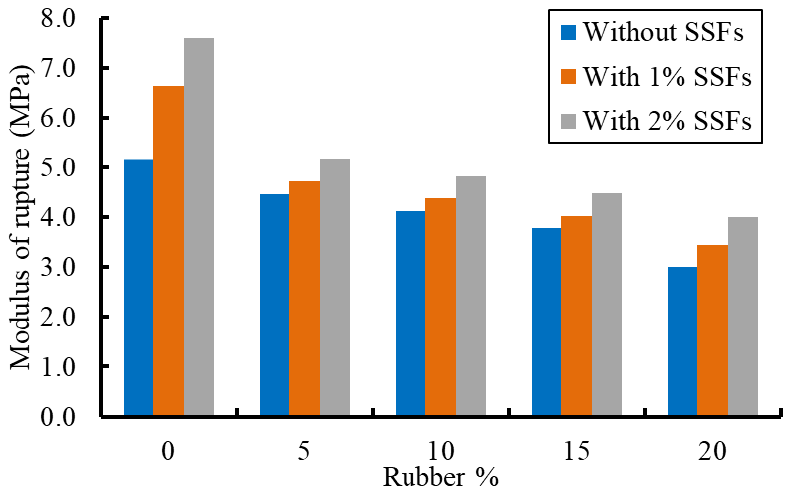
Figure 26. Bending test results (modulus of rupture).